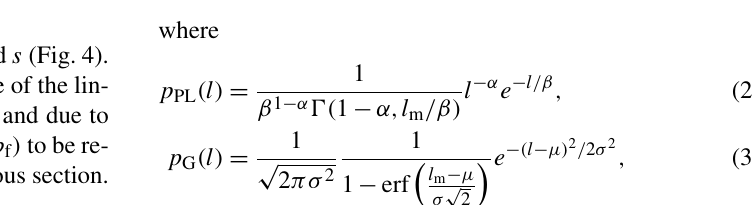
Figure 4. Scatter plot of the floe minor axis b f (m) vs. floe surface area s (m 2 ). Data from all five tests. The slope of the black line equals